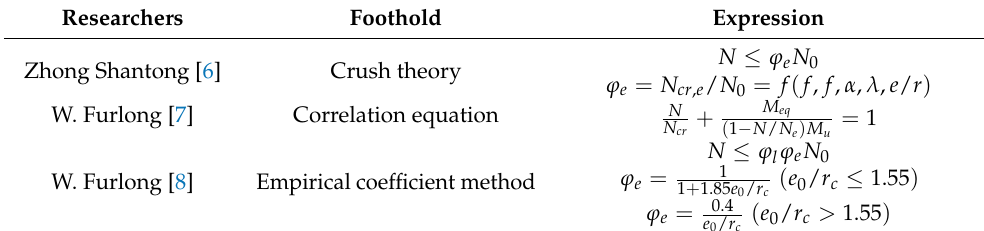
Table 2. Eccentric stability bearing